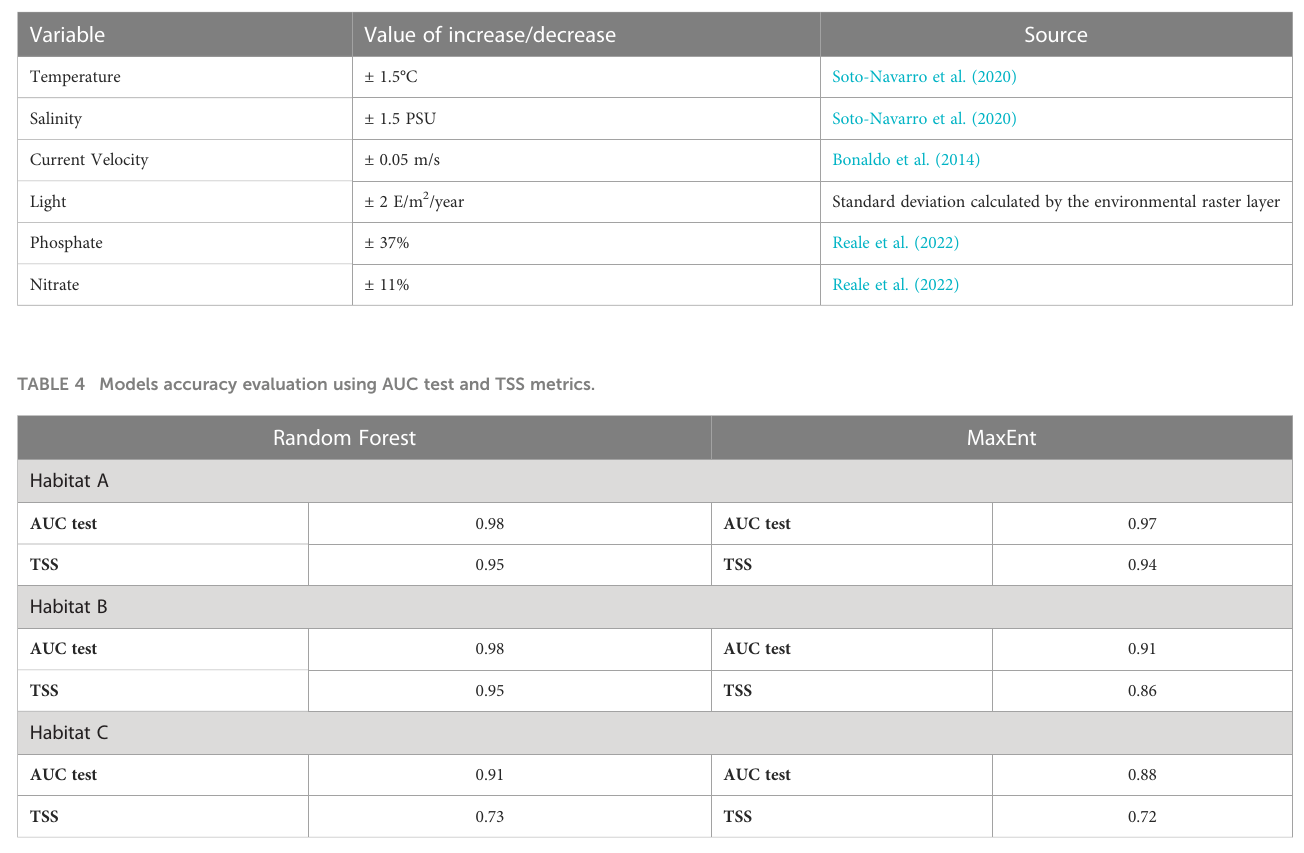
TABLE 3 Perturbation values for the sensitivity analysis.